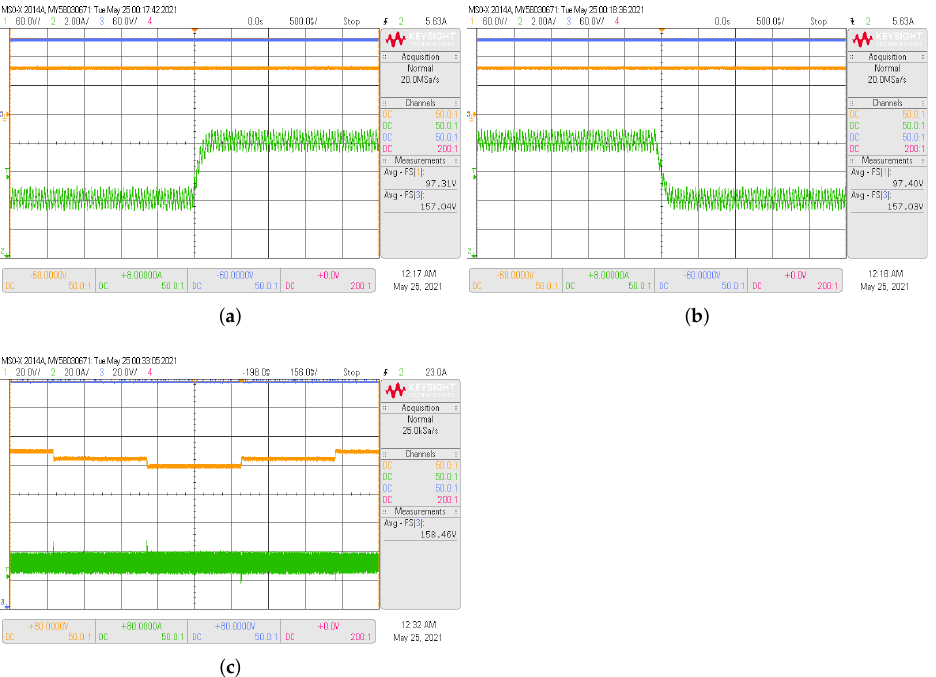
Figure 6. Experimental ( a , b ) responses of the sliding digital current input control when the reference i ref : ( a ) changes from 4 to 8 A, and ( b ) from 8 to 4 A. The converter operated with an input